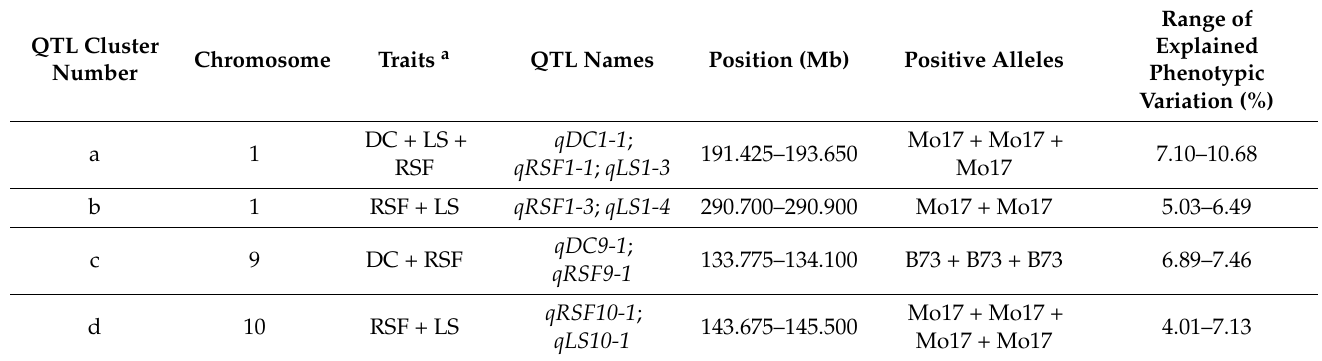
Table 5. QTL clusters for the embryogenic callus induction traits in the IBM Syn10 DH population across three